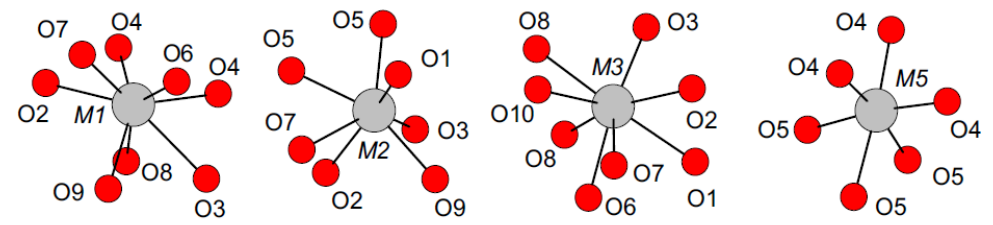
Figure 3. M1, M2, M3 and M5 cationic sites in RE β-TCP [64].